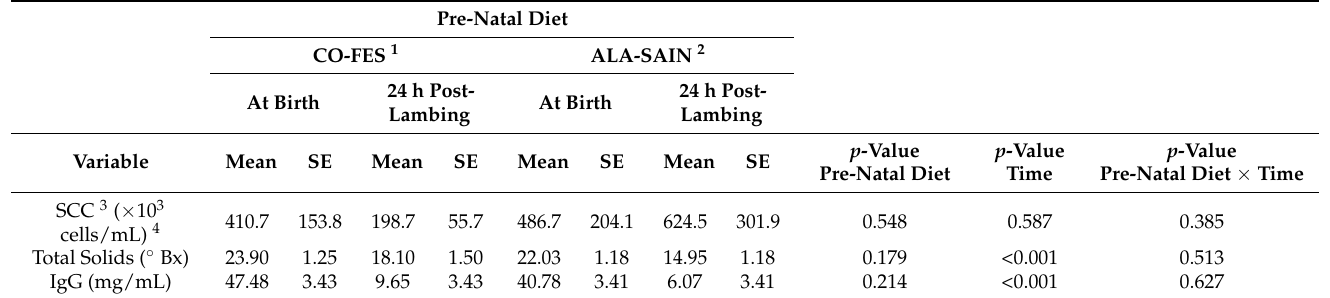
Table 4. Effect of pre-natal diet on colostrum somatic cell counts (SCC), total solids and IgG concen- tration at birth and 24 h